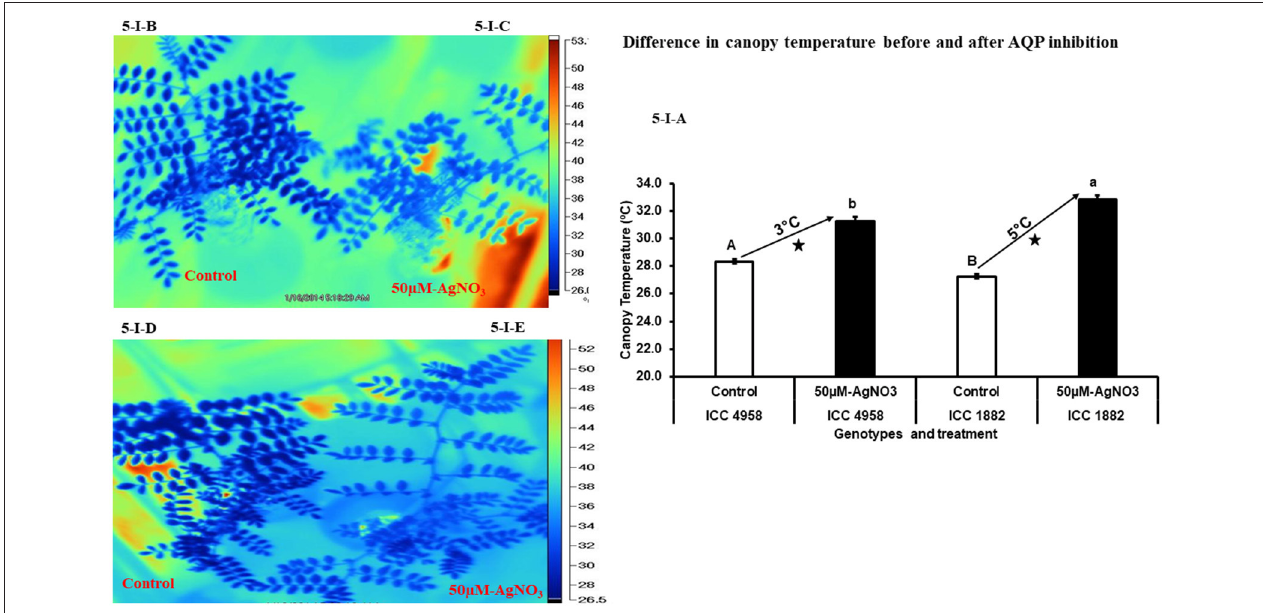
FIGURE 5 | Variation in canopy temperature after treatment with aquaporin inhibitor (50 µ M-AgNO 3 ) for two chickpea parental genotypes contrasting for plant vigor. In the picture dark blue represents the control and light blue represents the treated plants. An open and closed bar indicates the canopy temperature of control and treated plants. The picture (5-I-A) represents silver inhibition and canopy temperature in non-inhibited (control) and inhibited (50 µ M-AgNO 3 treated) plants. Bars with different capital letters (A and B) and small letters (a and b) indicate significant differences ( P < 0.05) in non-inhibited (control) and inhibited (treated) plants. The symbol star indicates the significantly different ( P < 0.05) between non-inhibited (control) and inhibited (treated) plants. The picture ( 5-I-B) represents late vigor genotype ICC 1882 control, ( 5-I-C) represents late vigor genotype ICC 1882 treated, ( 5-I-D) represents early vigor genotype ICC 4958 control and (5-I-E) represents early vigor genotype ICC 4958